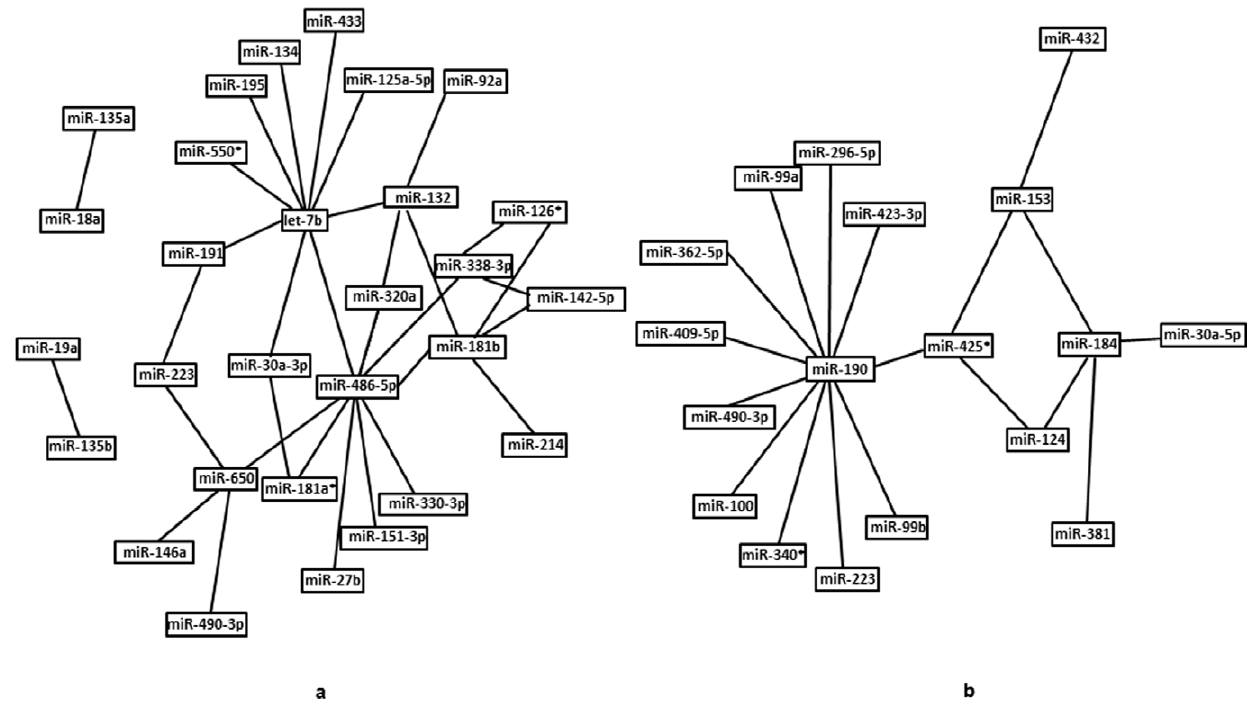
Figure 3. Network of microRNAs pairs in normal control and depressed groups. A . Network of microRNA pairs that showed no significant correlation in the normal control group yet did exhibit a significant positive correlation in the depressed suicide group. See text for details. B . Network of microRNA pairs that showed significant positive correlations in the normal control group yet were not correlated in the depressed suicide group. See text for details.